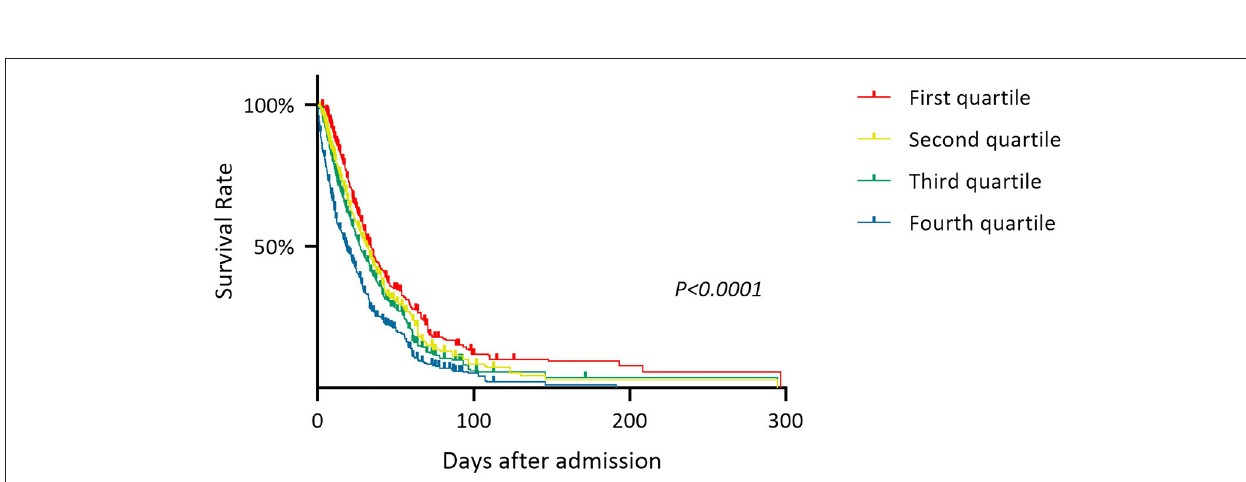
FIGURE 3 | Overall survival expectations of sepsis patients with different Lac/A1b